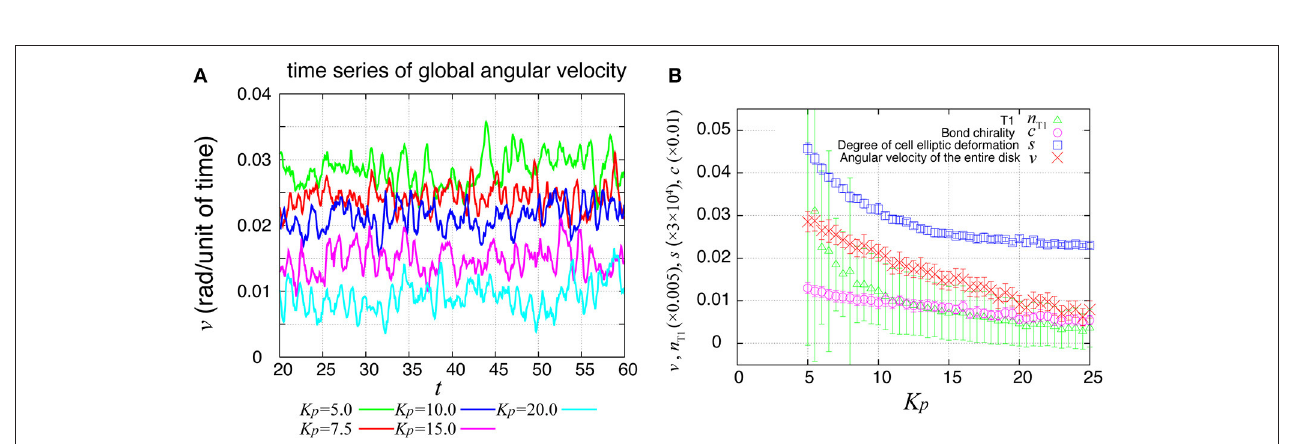
FIGURE 7 | Global angular velocity in the presence of line tension fluctuation. (A) Time evolution of the global angular velocity of an entire ring-like tissue for various values of K p . (B) K p -dependence of the global angular velocity. To calculate the K p -dependence, the angular velocity was averaged over the time window from t to 60. Error bars indicate standard deviation in the time